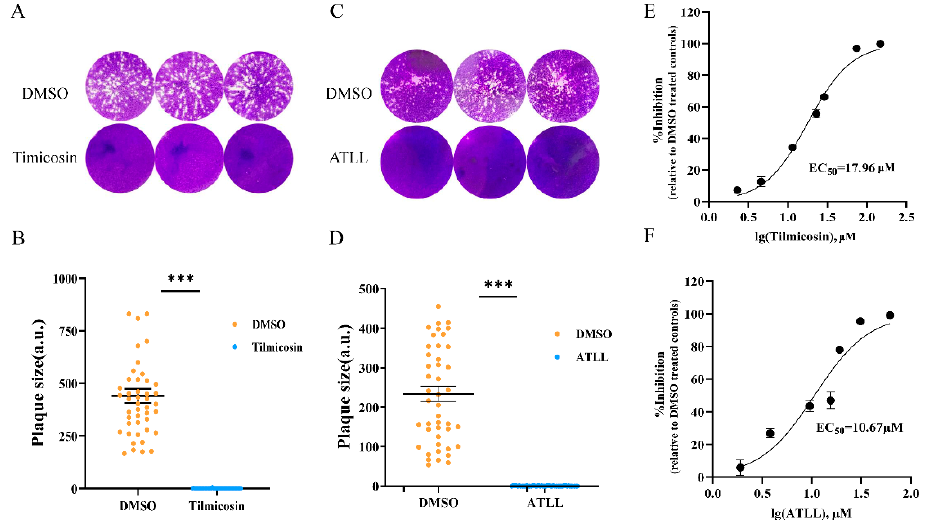
Figure 2. Potent inhibition of T. gondii growth by tilmicosin and ATLL. ( A ) Comparison of tilmicosin- or DMSO-treated parasite growth for plaque assays. Each well was infected with 200 parasites and grown for 7 d in the absence or presence of 23 µ M tilmicosin. ( B ) Calculation of plaque areas by randomly selecting at least 20 plaques and measuring them using pixel points in Photoshop C6S software (Adobe, San Jose, CA, USA). Data were compiled from three independent experiments. ( C ) Comparison of plaque assays for parasite growth with 17 µ M ATLL or DMSO treatment. ( D ) Statistics of plaque area after ATLL treatment. ( E , F ) Demonstration of a dose-dependent inhibitory effect of Tilmicosin or ATLL on T. gondii . Parasites were allowed to infect Vero cells for 24 h, then compound dilutions were added and incubated for 24 h. The EC 50 was calculated using the log (inhibitor) versus response-variable slope (four-parameter) regression equation in GraphPad Prism 8 (GraphPad, La Jolla, CA, USA). Means ± standard deviations (SD) are shown for the results of three independent experiments, each condition containing three replicates. The EC 50 for tilmicosin and ATLL was 17.96 µ M (95% CI, 16.58 µ M to 19.40 µ M) and 10.67 µ M (95% CI, 8.684 µ M to 12.84 µ M), respectively. Asterisks indicate statistically significance. *** p <